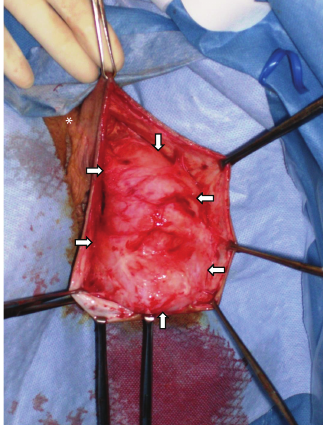
Figure 2: Intraoperative image delineating the borders of the vulvar AA (arrows) and the clitoral hood (asterisk).